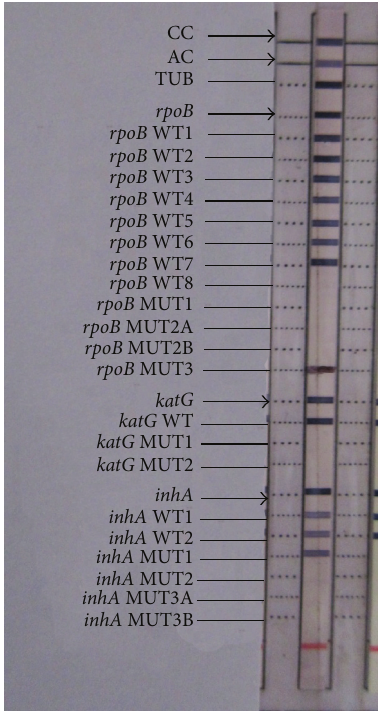
Figure 4: Patient with inhA MUT1 band along with wild type bands indicating low level INH heteroresistance.